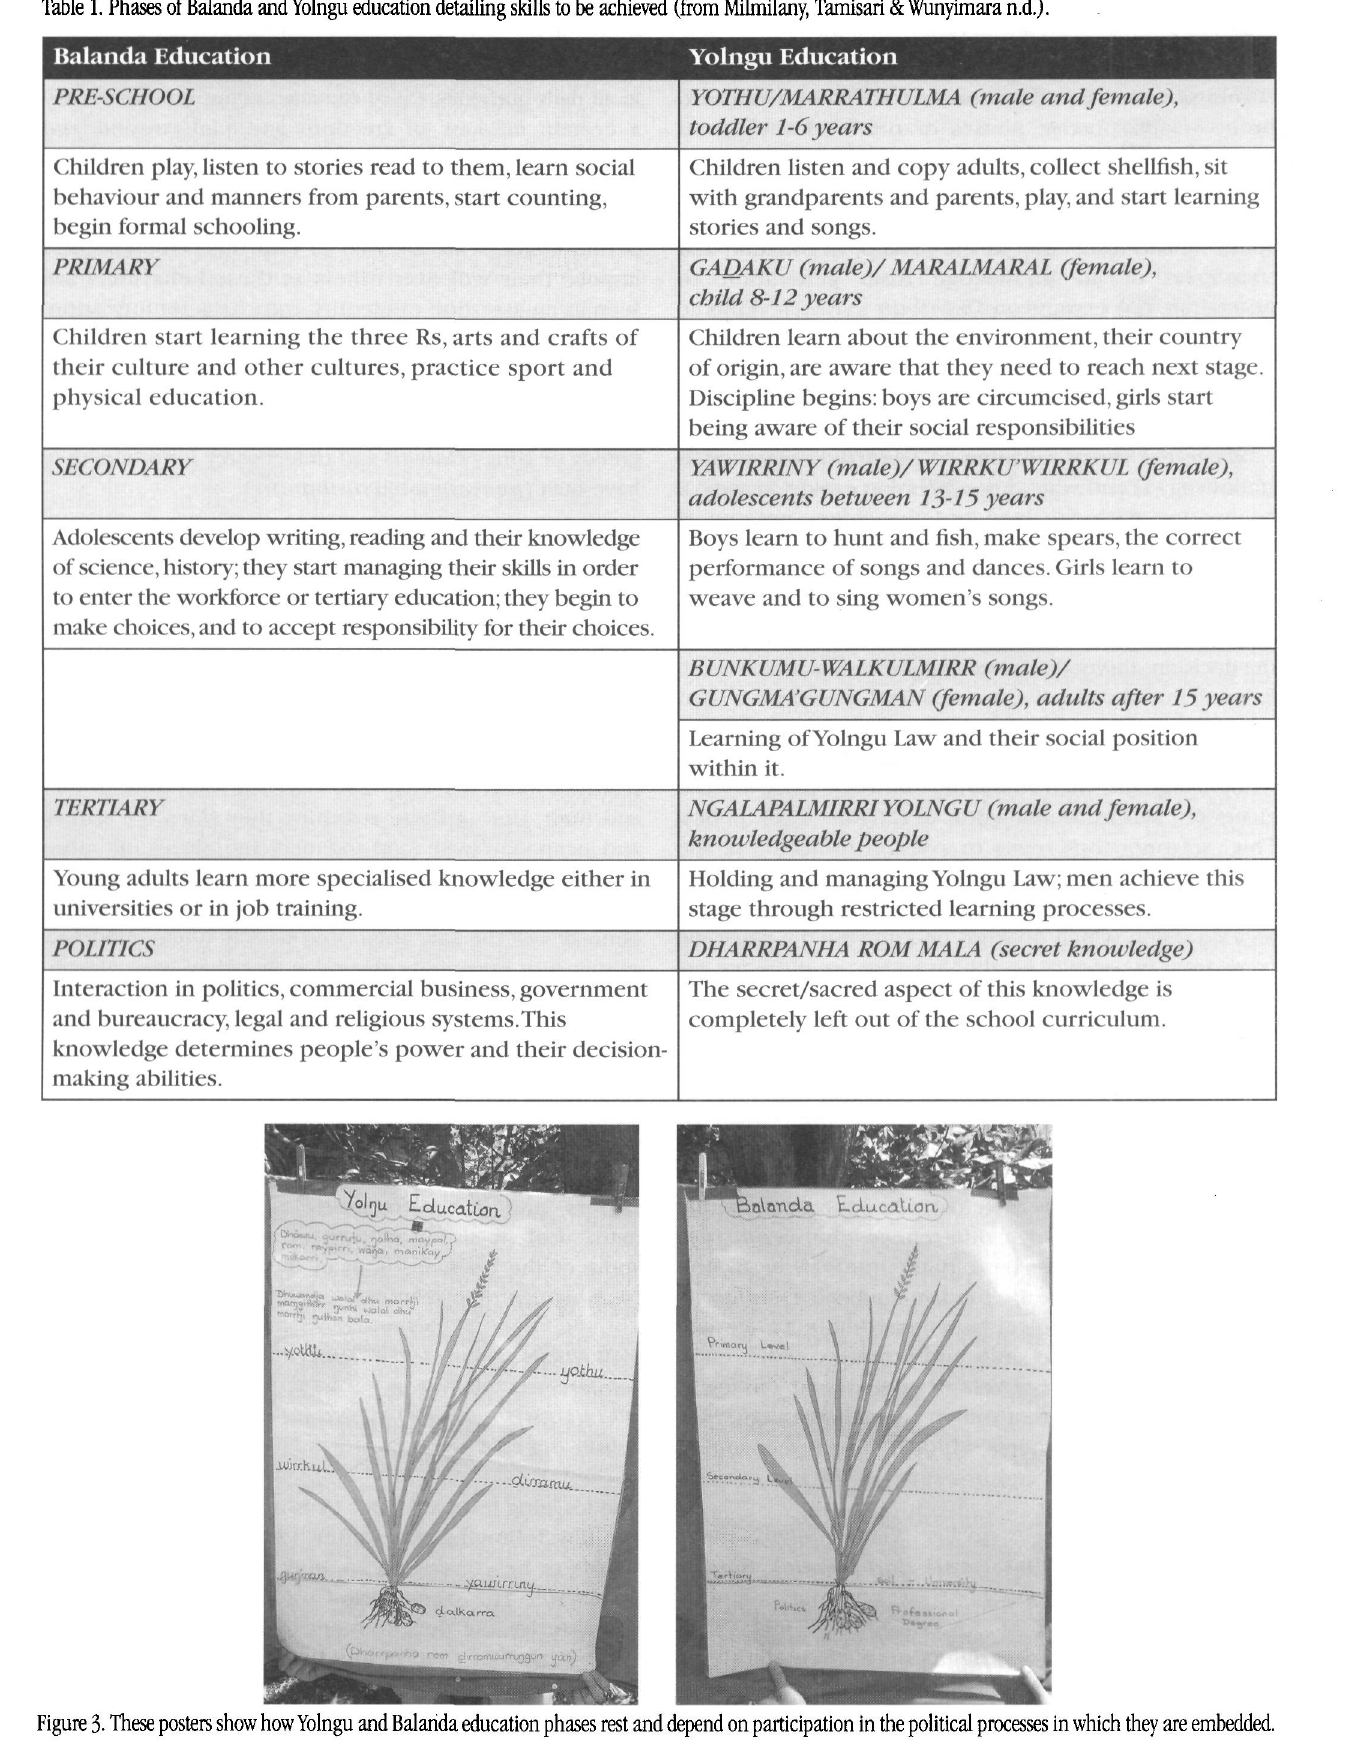
Table 1. Phases of Balanda and Yolngu education detailing skills to be achieved (from Milmilany, Tamisari & Wunyimara n.d.). Balanda Education